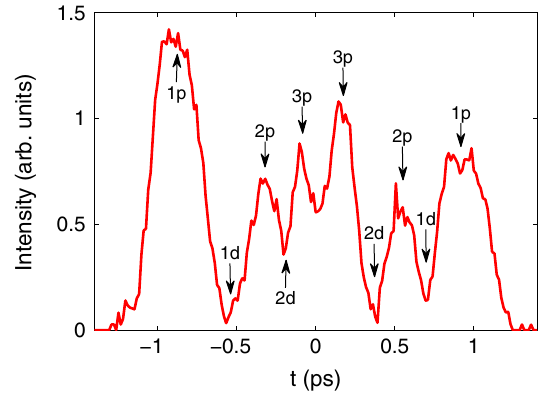
FIG. 8. Projected time-dependent COTR intensity for Fig.